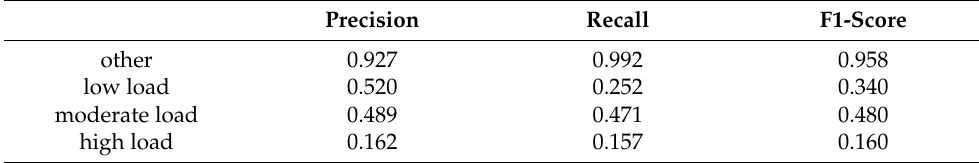
Table 2. Precision, recall, and F1-scores for the classifier’s performance on the test dataset. Precision